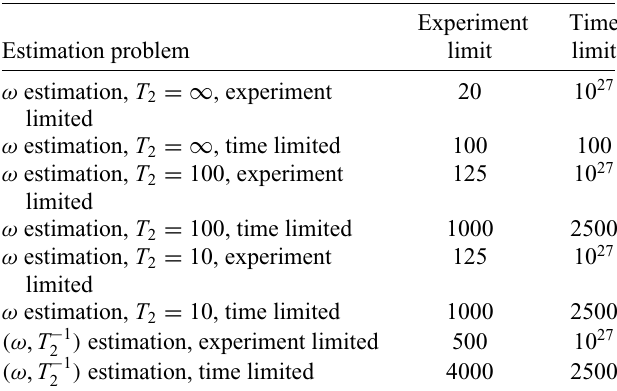
TABLE I. Limits on the number of experiments and the avail- able time for all estimation problems considered in this